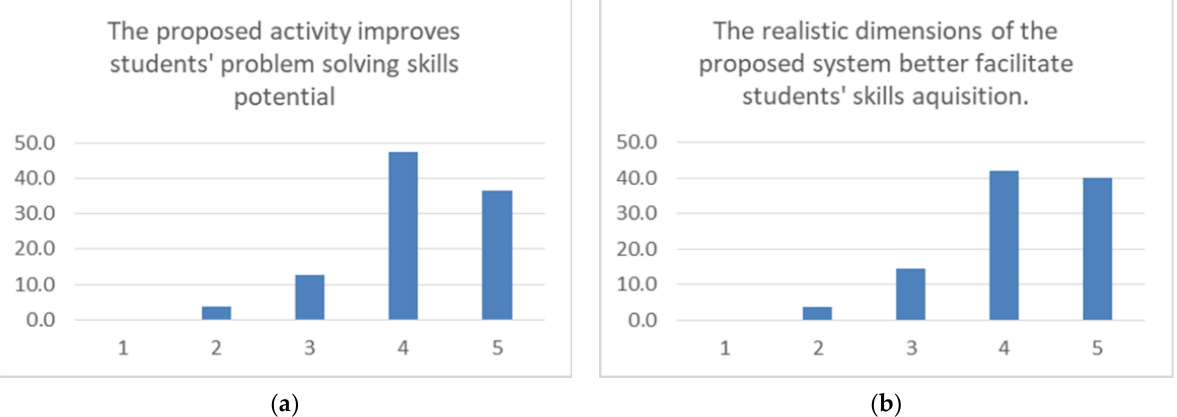
Figure 19. Opinion about: ( a ) the contribution of the proposed activity to problem solving skills acquisition by the students; ( b ) the degree to which the realistic dimensions of the system being upgraded better served the skills’ acquisition, compared with a miniature